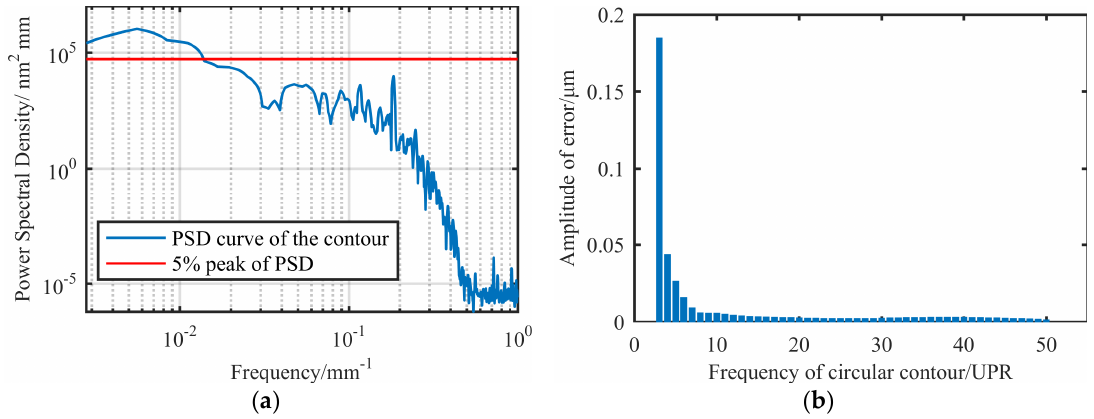
Figure 10. Analysis of amplitude–frequency characteristics of contour: ( a ) power spectral density (PSD) characteristic curve; ( b ) error amplitude of different frequency components.